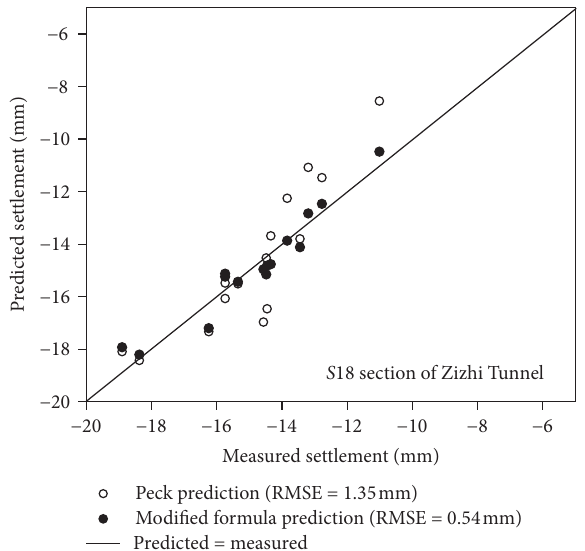
Figure 12: Comparison of predicted settlements for the S 18 section inside the river-affected area.